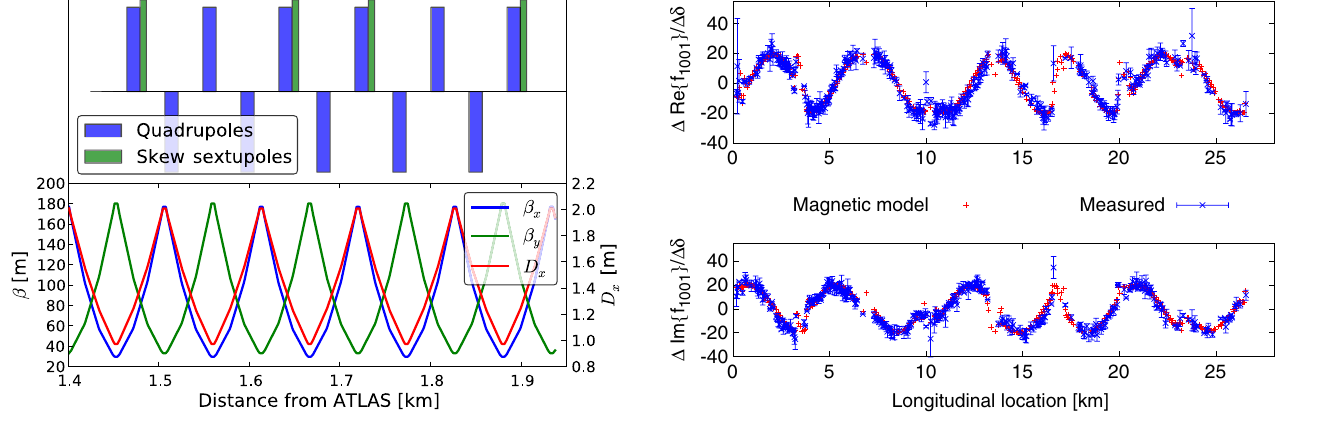
FIG. 2. Comparison between the measured chromatic coupling (blue) and the expected chromatic coupling from our magnetic model (red). This is for beam 1 at injection.